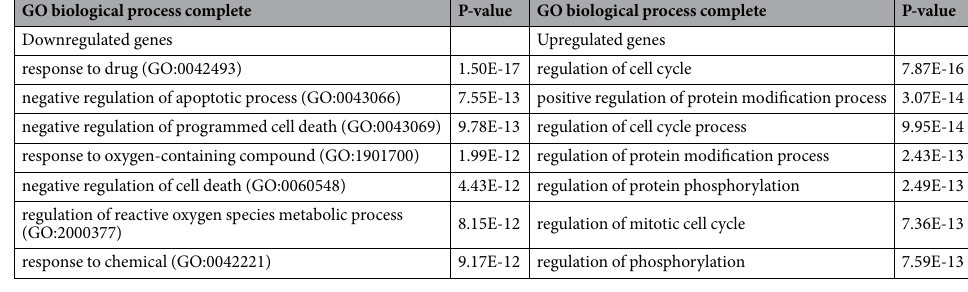
Table 1. GO term enrichment in top upregulated and down regulated genes in PRMT1 knockout mice fed